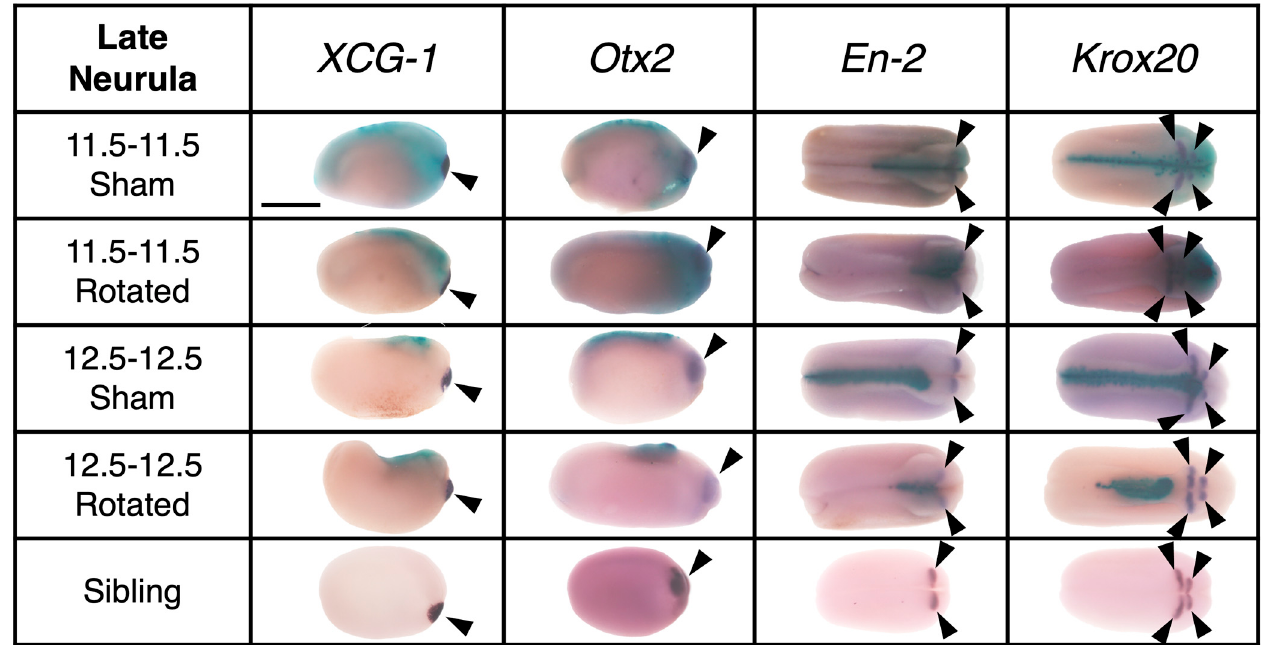
Figure 5. Representative examples of expression of regional marker genes in transplants and sibling controls at late neurula stage (St. 18). With a lateral view with dorsal facing up for XCG-1 and Otx2 , and dorsal view for En-2 and Krox20 , anterior is to the right in all images. Purple stain marked with a solid arrowhead indicates gene expression and aqua blue stain was used to indicate transplant incorporation. Scale bar represents 1 mm.